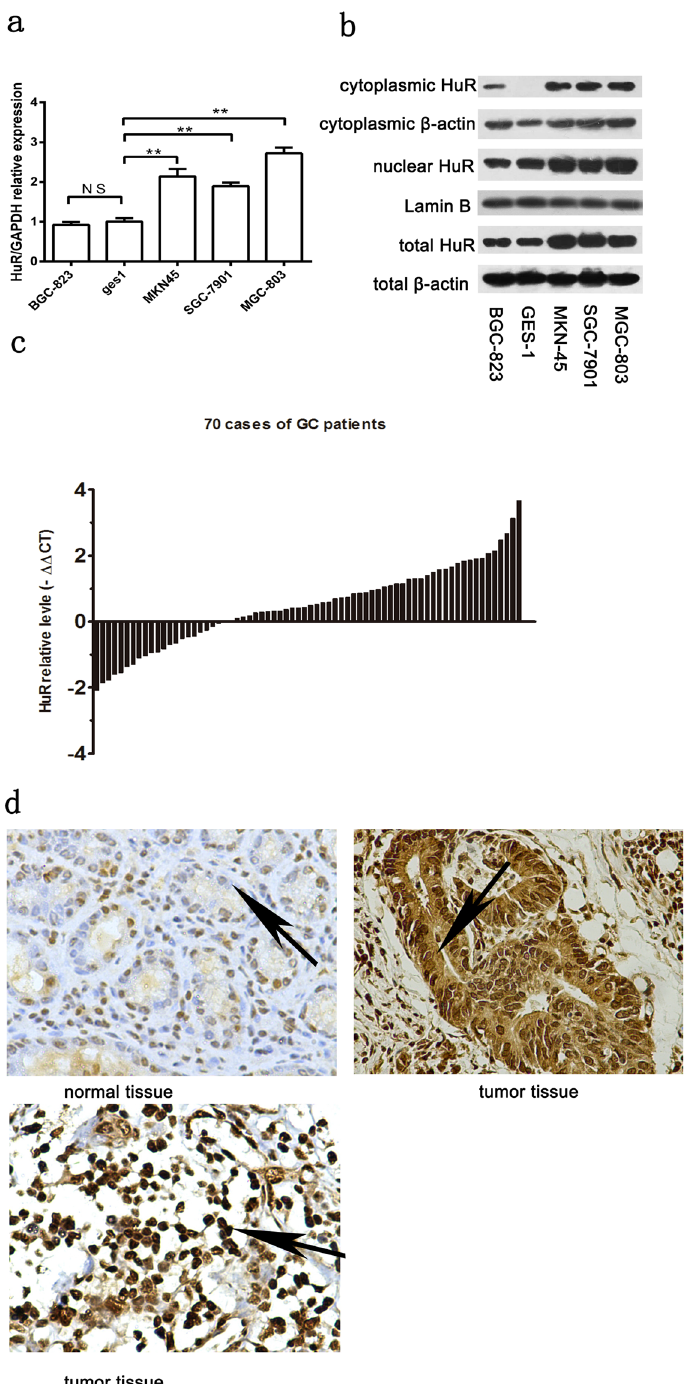
Figure 1. Expression of HuR was elevated in GC. ( a ) HuR mRNA expression was evidently higher in MGC- 803, SGC-7901 and MKN-45 cell lines than in the non-malignant GES-1 cells. The data were represented as the mean ± SD. ** p < 0.01. ( b ) Positive cytoplasmic HuR expression was detected in MGC-803, SGC-7901, MKN- 45, and BGC-823 cells, whereas no cytoplasmic expression of HuR was found in GES-1 cells. ( c ) Increased HuR mRNA levels were observed in 70% (49/70) patients. ( d ) Representative images of the immunohistochemistry analysis of HuR expression in tissues. Normal mucosae only showed a weak nuclear expression of part cells (top and left). However, cancer tissues exhibited a pattern of high nuclear expression (bottom and left), and an aberrant cytoplasmic distribution (top and right) was detected in (22/70)